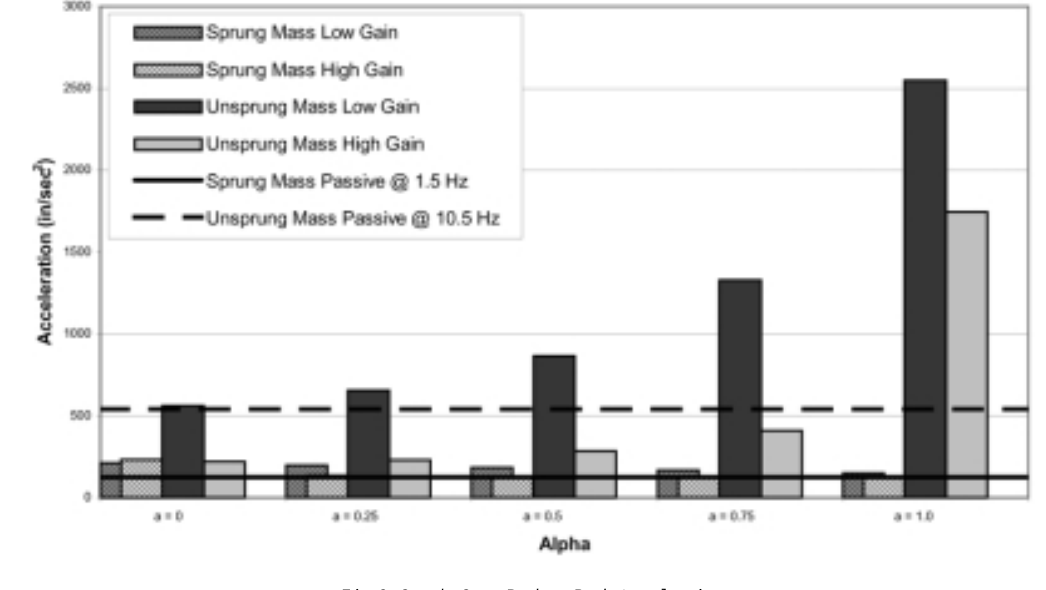
Fig. 8. Steady-State Peak-to-Peak Acceleration.